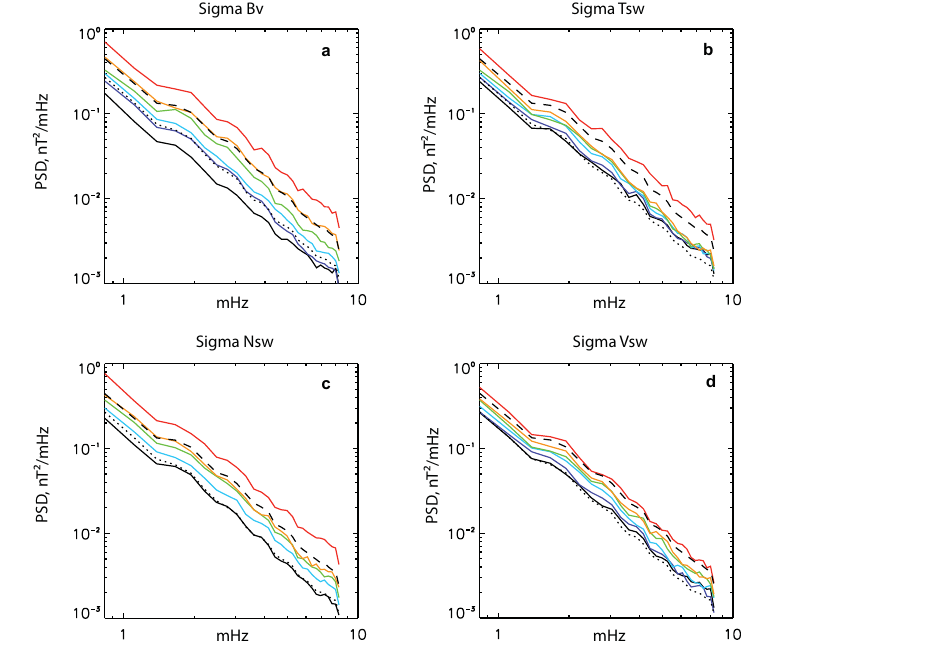
Figure 1. ULF wave power spectral density (PSD) as a function of solar wind variability. Median values of radial magnetic field ( B x component) PSDs are computed between sextiles of standard deviations of (a) interplanetary magnetic field vector, (b) solar wind ion temperature, (c) solar wind plasma density and (d) solar wind flow speed. The sextiles of solar wind variability are computed for the conditions when mean solar wind speed exceeds 450kms − 1 . Dotted lines and dashed lines indicate the median values of GOES PSDs for all solar wind conditions when the mean solar wind speed exceeds 400 and 500kms − 1 , respectively. For reference, the values of median and upper sextile of the solar wind parameters are given here: for σ(B V ) are 2.5 and 4.0nT, for σ(T SW ) are 1 . 86 × 10 4 and 3 . 89 × 10 4 K, for σ(N SW ) are 0.3 and 0.7cm − 3 and for σ(V SW ) are 9 and 16kms − 1 , for the median and the upper sextiles,